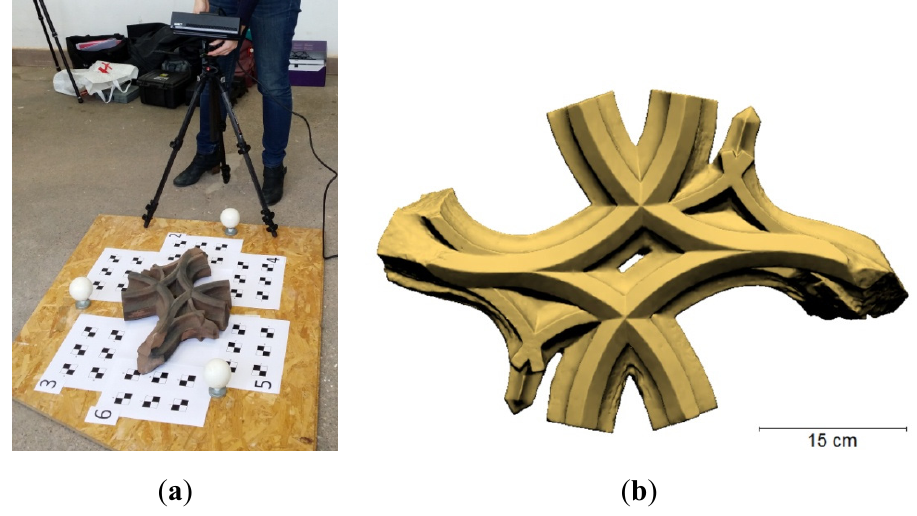
Figure 10. ( a ) Object under study (a sandstone balustrade fragment); and ( b ) reference mesh realized after acquisition with a measuring